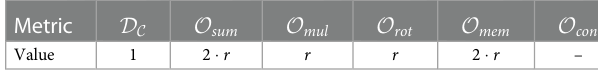
Algorithm 10 Rotation r times of V cleartext vector encoded in multiple ciphertexts v 0 ; v 1 ; ... ; v n . function ROTATE ({ f c t 0 ; c t 1 ;:::; c tr [ Z Q ½ x (cid:3) = h x N þ 1 ig ¼ E ð p k ; M Þ , rot ) q ;